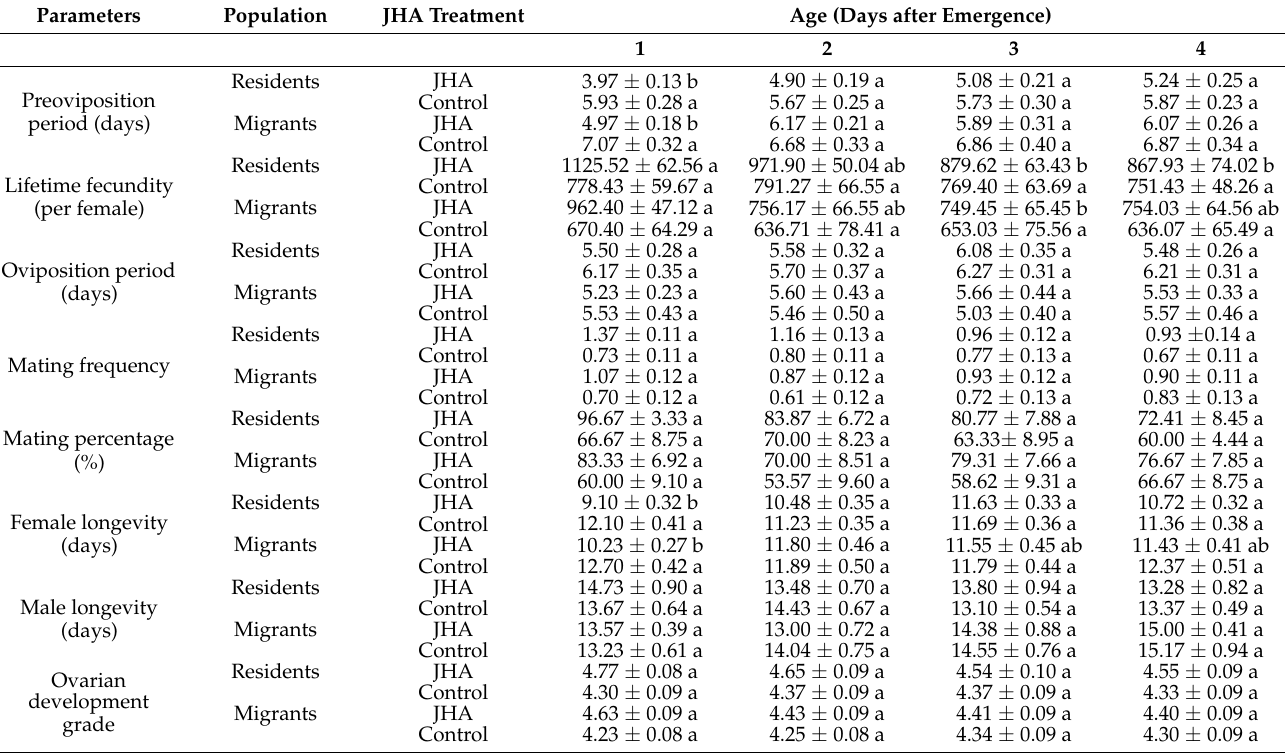
Table 3. Effect of age on reproductive performances of M. separata populations treated by